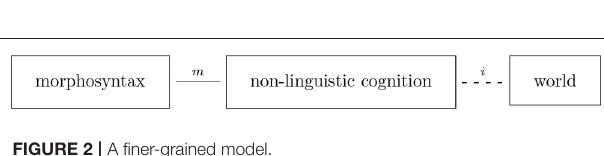
FIGURE 2 | A finer-grained